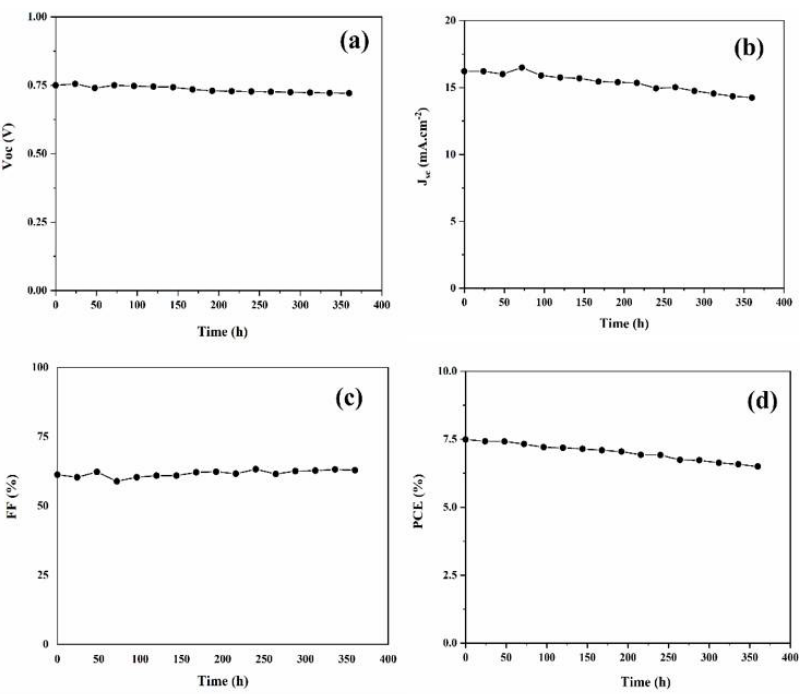
Figure 5. Device stability test under illumination for DSSC made of 2-L@F@CB CE. ( a ) Voc, ( b ) Jsc, ( c ) FF, and ( d )